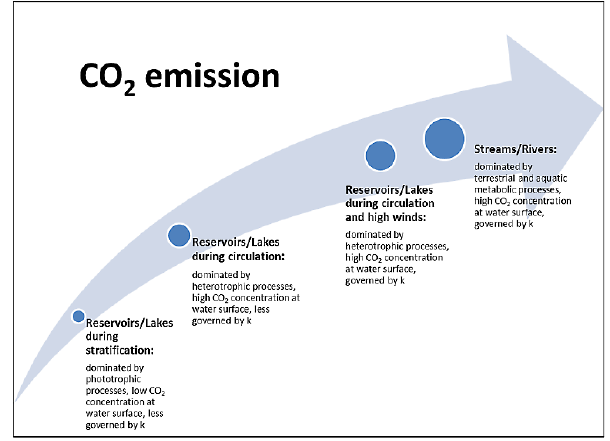
Fig. 8. Schematic presentation of the effect of different regulation mechanisms on CO 2 emissions (per unit area) from streams and low-wind